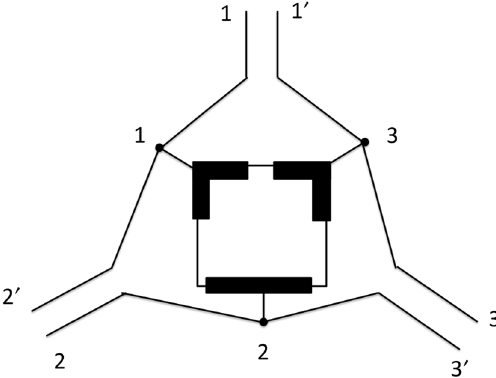
FIG. 12. A dual construction of Carlin [56,57] for realizing a circulator with the same three-terminal device as in Fig. 11. Phase-inverted circulation is achieved; i.e., the S matrix is the negative of Eq. (1).